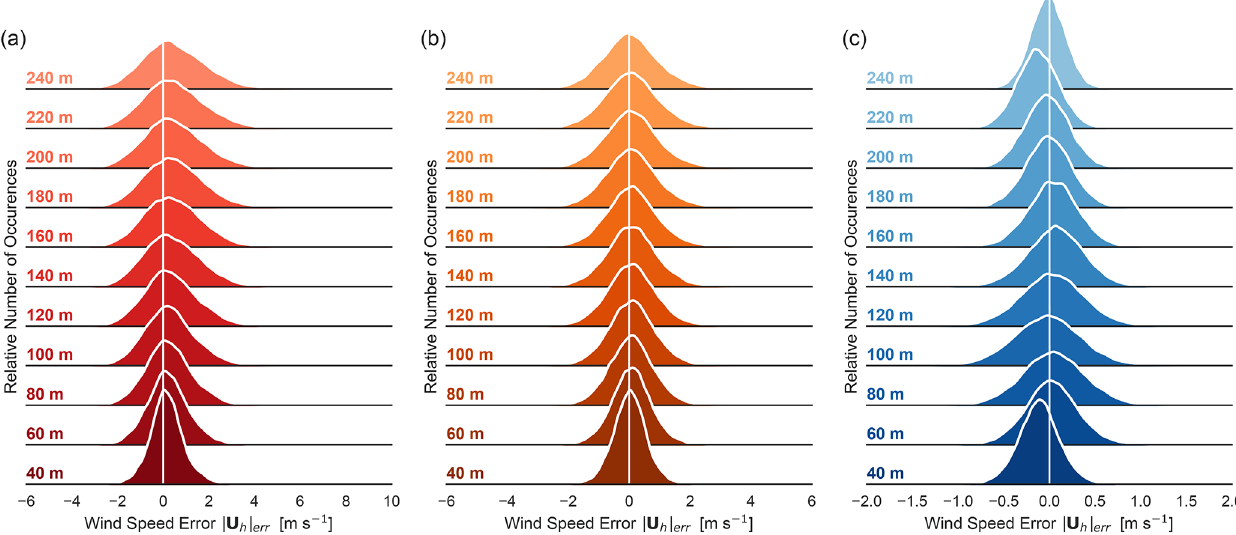
Figure 6. Kernel density estimates of the 1Hz wind speed error distributions. Errors are computed with respect to the volume average at each height for the (a) strong CBL, (b) weak CBL, and (c) stable boundary layer (BL). Each distribution comprises 108000 data points.